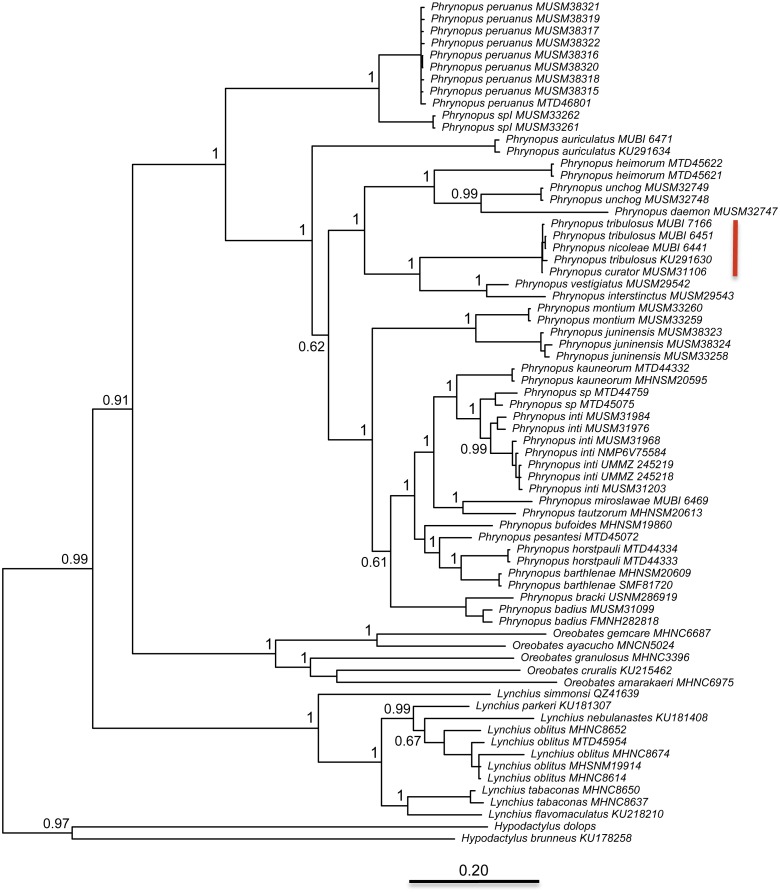
Phylogeny.Bayesian maximum clade-credibility tree for species included in this study based on a 2,646-bp concatenated partitioned dataset (16S, 12S, COI, RAG1, Tyr) analyzed in MrBayes (posterior probabilities are indicated at each node). The red bar indicates terminals representing Phrynopus tribulosus; two of these were recognized as Phrynopus nicoleae and Phrynopus curator in previous studies (see text for details).